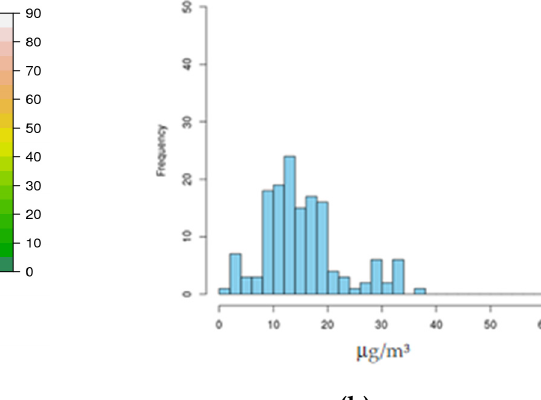
Figure 12. APS2025 PM 10 :( a ) ground level field( μ g/m 3 ); ( b ) frequency distribution of annual average concentration in background stations.